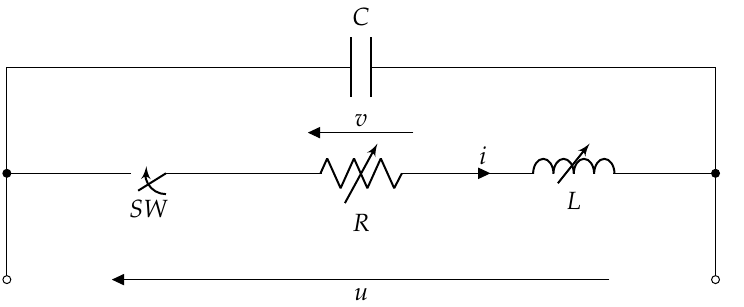
Figure 1. Equivalent circuit of a spark-gap consisting of nonlinear arc resistance R ( i , t ) , nonlinear arc inductance L ( i , t ) , spark-gap electrodes’ capacitance C , and a switch representing the presence of an arc channel